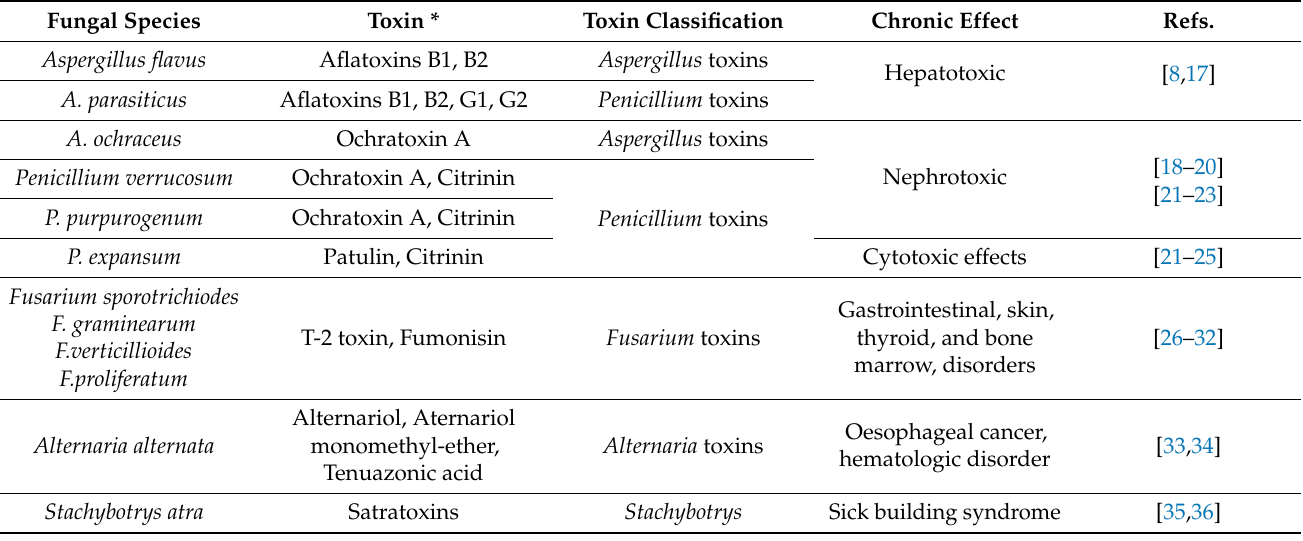
Table 1. Common toxigenic species of fungi and their chronic effects.